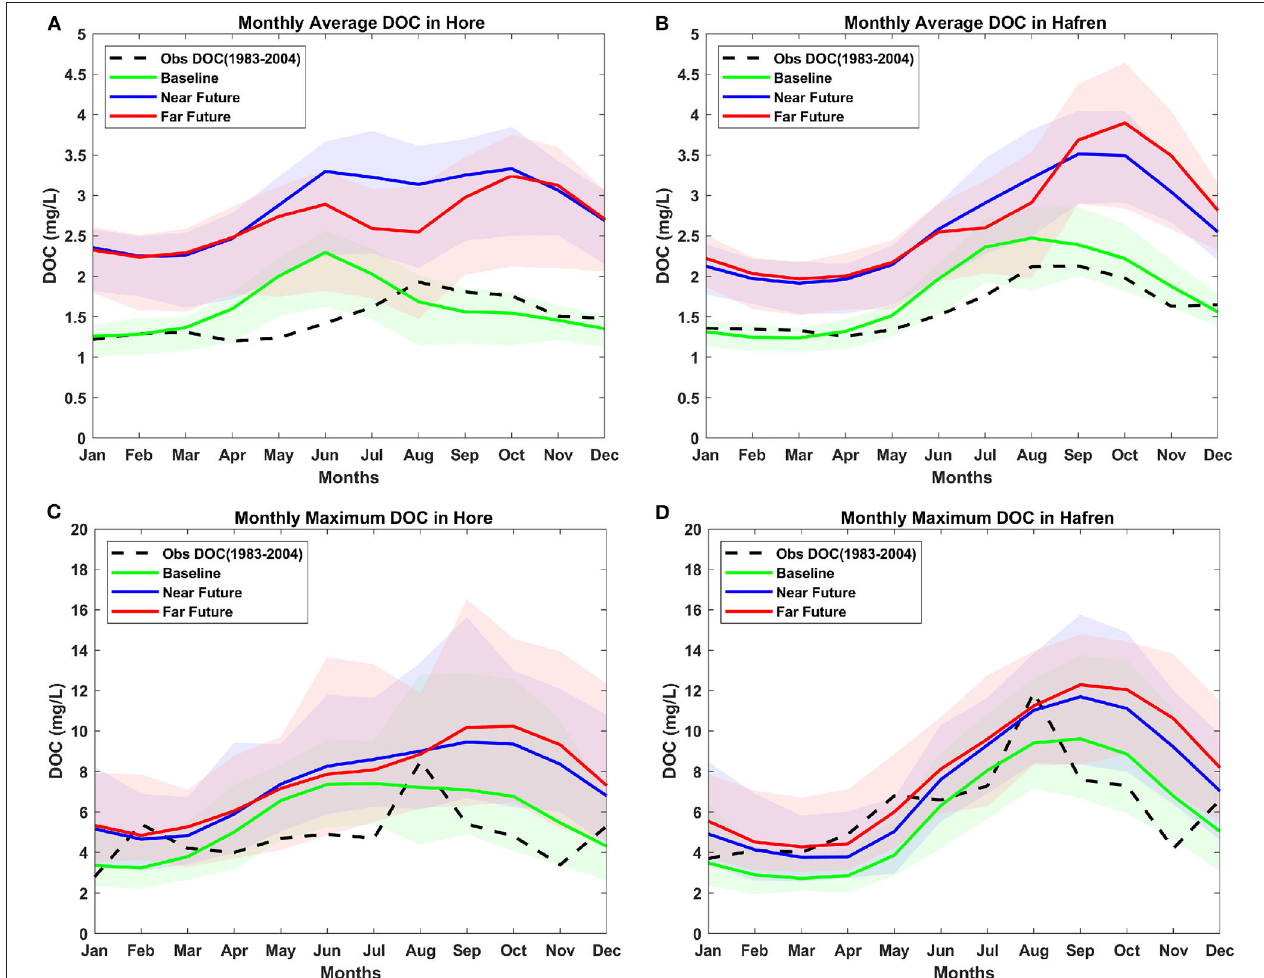
FIGURE 9 | Impact of climate change and acidic deposition (up to 2030) on the Upper Severn catchments; the simulated mean monthly DOC concentrations at the Hore (A) and Hafren (B) , the simulated monthly maximum DOC concentrations at the Hore (C) and Hafren (D) .